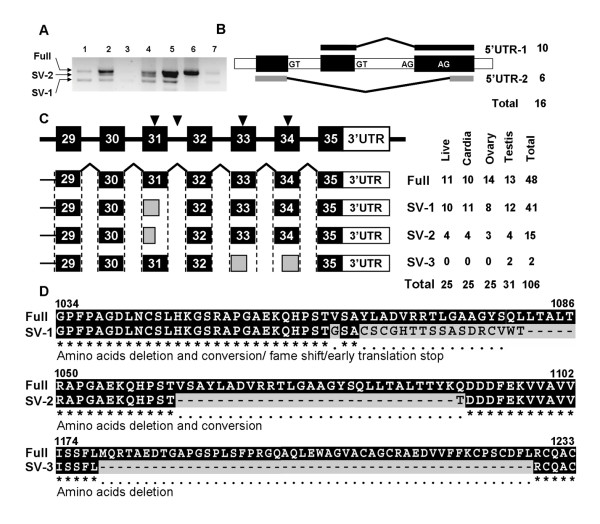
Bovine RTEL is alternatively spliced in both coding sequence and 5' untranslated region (5'UTR). Three splice variants were identified in cDNA from multiple adult tissues, two 5'UTR isoforms were obtained by 5'RACE from testis. A. Agarose gel electropherograms of the splice variants from various tissues developed by RT-PCR, line 1 to 7 presents lung, liver, pancreas, cardia, testis, ovary and spleen respectively. The arrows indicate the splice variant correspond to each band. B. Two forms of 5'UTR. The rectangles indicate the genomic regions that identical to the 5'UTR (not to scale), putative exonic and intronic regions are indicated by filled and opened rectangles, GT-AG splicing sites were also shown. Skipping of full or partial exons is presented by brackets above or below according to different forms. Numbers on the right shows the frequency to observe a given 5'UTR isoforms. C. Splice variants in coding region. Number labelled boxes indicate the genomic regions identical to cDNA (exons 29 to 35). Regularly and alternatively spliced exons are shown by black and grey boxes respectively below. SV is short for splice variants and Full means the full-length transcript. Numbers on the right shows the times an splice variant presents in the sequenced RTEL transcripts from indicated tissues. D. Amino acids changes caused by alternative splicing. The alignment figures display the changes at the protein level of three identified splice variants (SV-1 to SV-3) compared to full-length protein, identical residues are shown in black background whereas changed are indicated by grey.